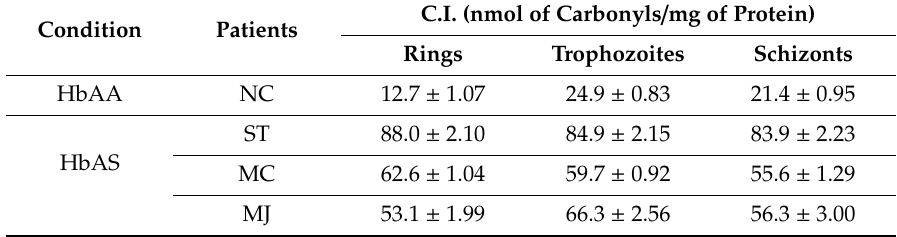
Table 1. Carbonyl index of P. falciparum proteins at di ff erent asexual stages in HbAA and HbAS erythrocytes.